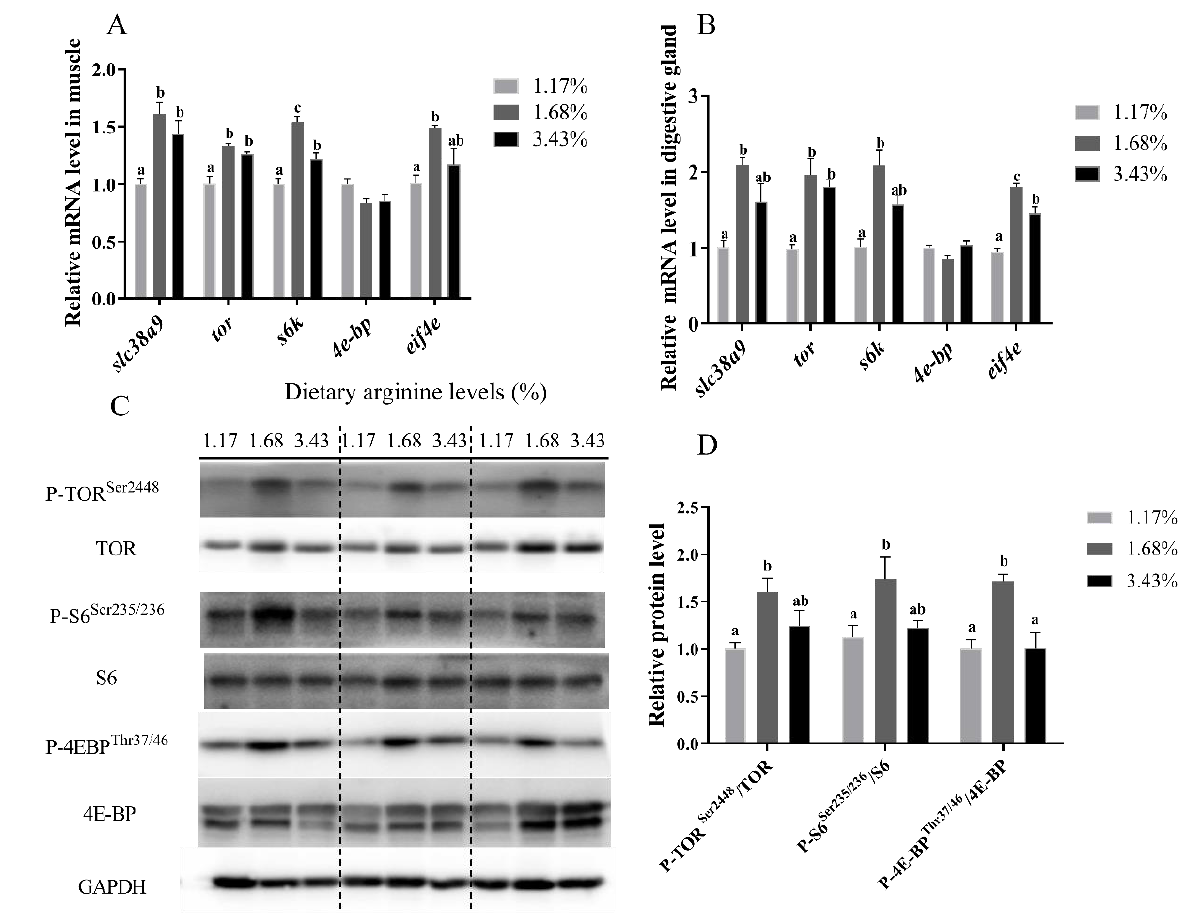
Figure 8. Effect of arginine on TOR signaling pathway of abalone in vivo. The expression levels of slc38a9 , tor , s6k , 4e-bp and eif4e in muscle ( A ) and digestive gland ( B ) of abalone fed diets with different arginine levels (1.17%, 1.68% and 3.43%) for 120 d. ( C , D ) The abundance of phosphorylated TOR, Ribosomal S6 (S6) and 4E-BP protein in muscle of abalone fed diets with different arginine levels for 120 d. Results are represented as mean ± SEM (N = 3 replicate experiments), and different lowercase letters (a < b < c) indicate significant differences among groups ( p < 0.05).